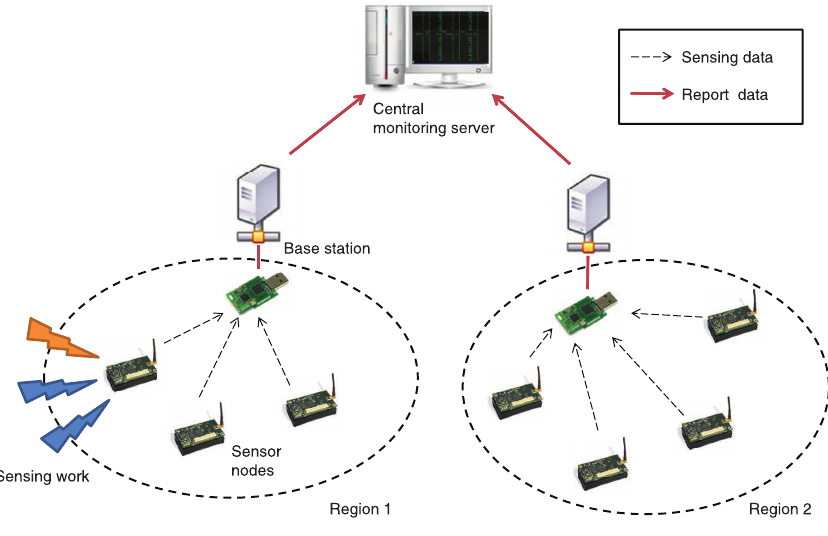
Figure 3. The division of processes of the distributed WM